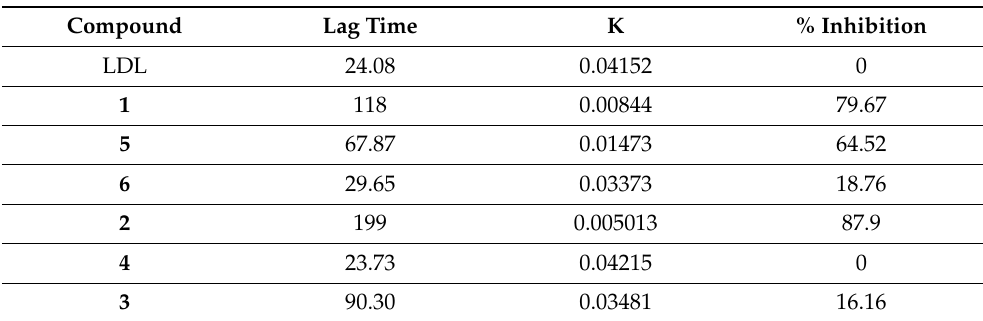
Table 2. Effect of rePON1 in a complex with the synthesized lipids on lag time, rate constant of the oxidation propagation (K), and % inhibition of LDL oxidation. See Figure 1 for compounds corresponding to each